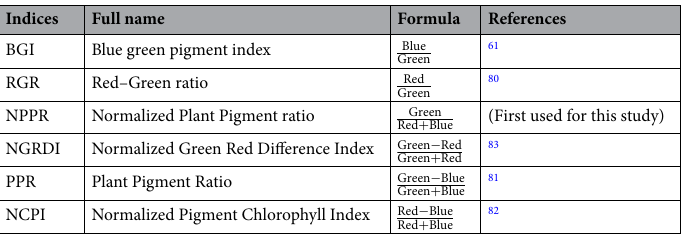
Table 4. Vegetation indices derived from aerially collected red–green–blue (RGB) images of peanut plots in 2017 and 2019.